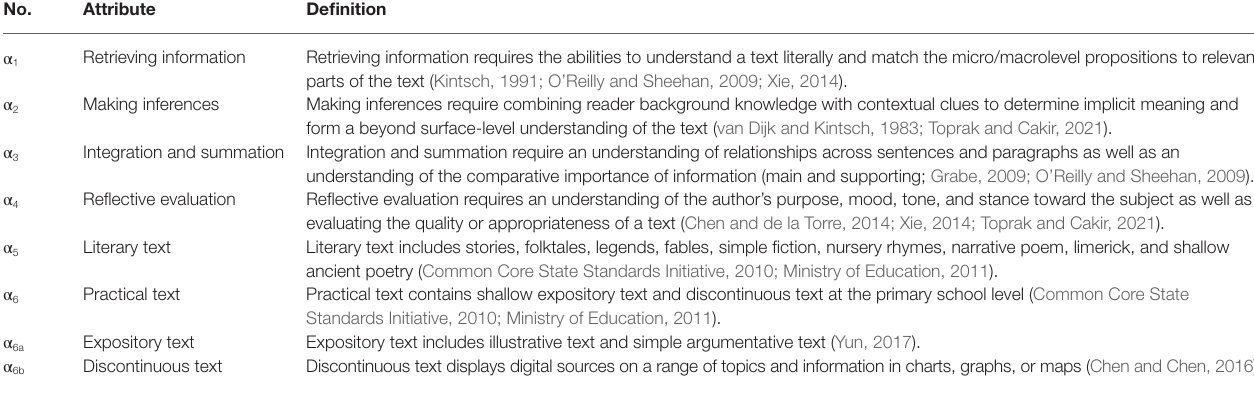
TABLE 1 | Definitions of the initial reading